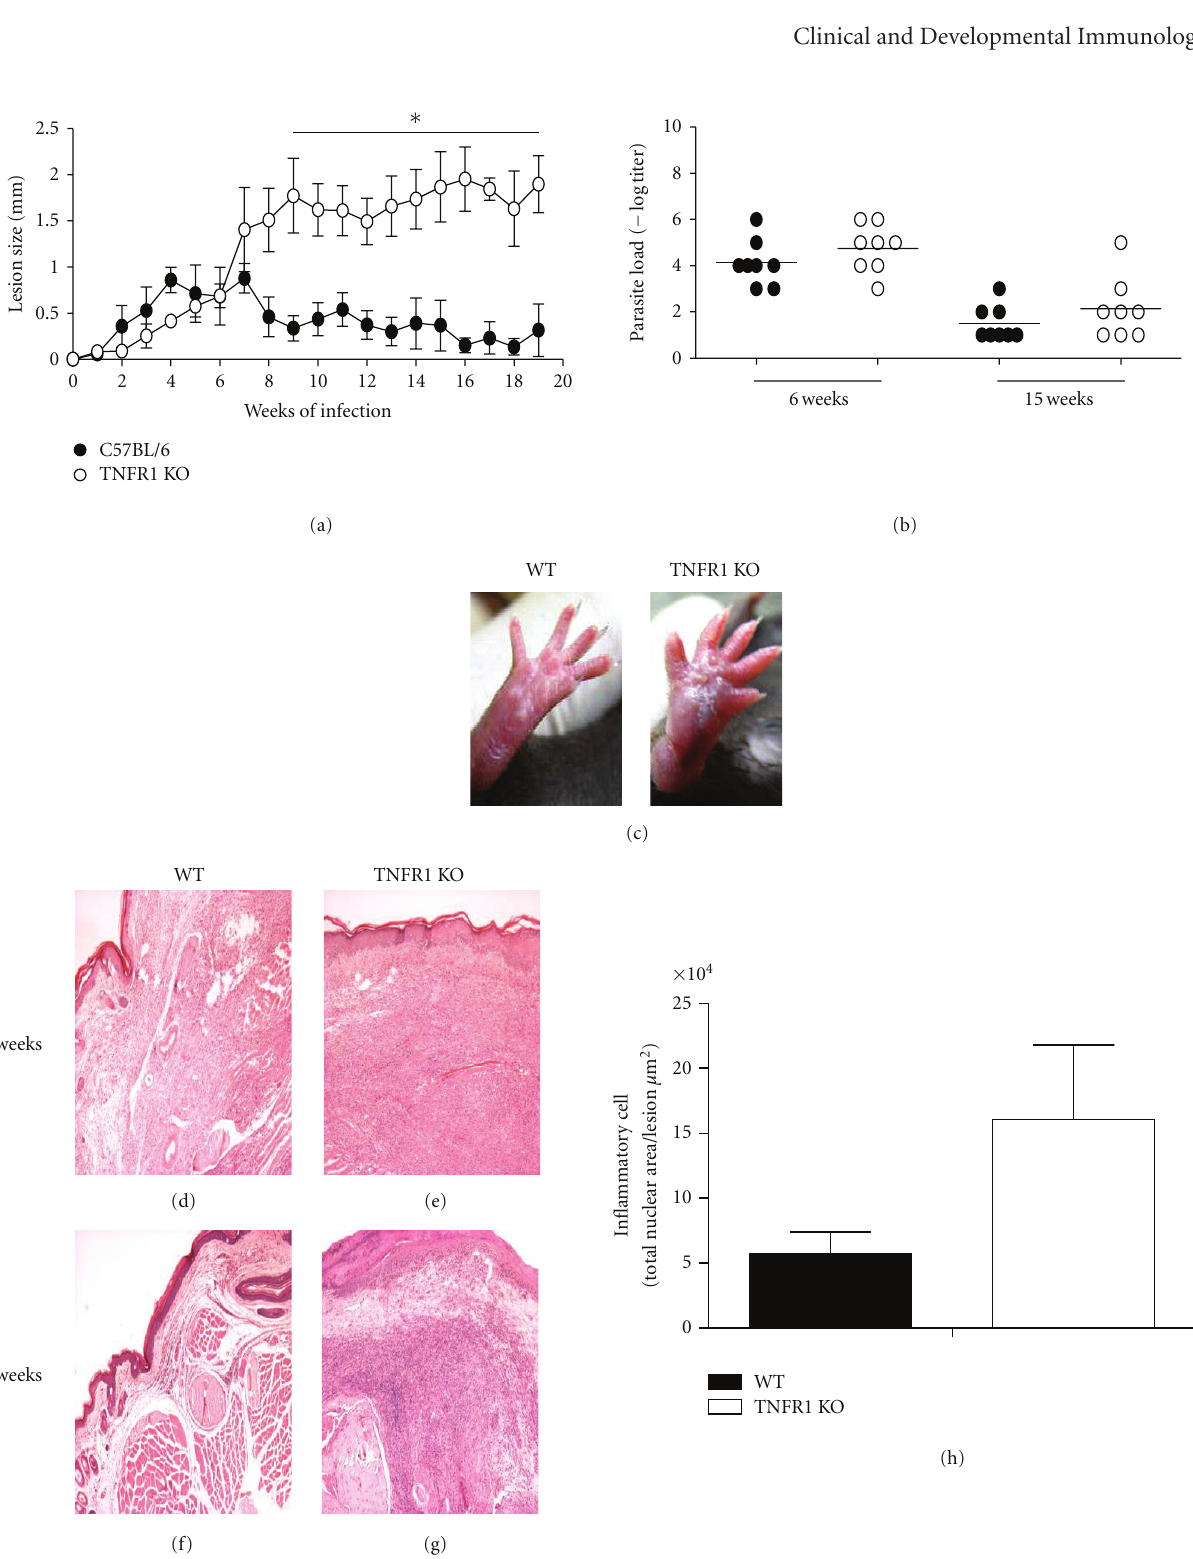
Figure 1: Lesions and parasite burdens in TNFR1 KO mice with L. major . Mice were infected with 1 × 10 6 metacyclic stationary forms of L. major in footpads. (a) The footpads were measured weekly and the value for uninfected mice was subtracted from each infected footpad to estimate lesion size. (b) Parasite burden in WT and TNFR1 KO mice. Mice were sacrificed at 6 and 15 weeks afterinfection and parasite burden was determined by limiting dilution analysis ( n = 5 mice per time point). (c) Lesions from WT and TNFR1 KO mice infected with L. major 15 weeks afterinfection. (d–g) Histological aspect of tissues from lesions from WT and TNFR1 KO infected for 6 weeks (d and e) or 15 weeks (f and g), stained with hematoxylin and eosin. (h) Morfometric quantification of inflammatory cells from WT and TNFR1 KO lesions 15 weeks afterinfection ( n = 4 mice per group). ∗ indicates P < 0 . 05. Data are from one experiment of three performed